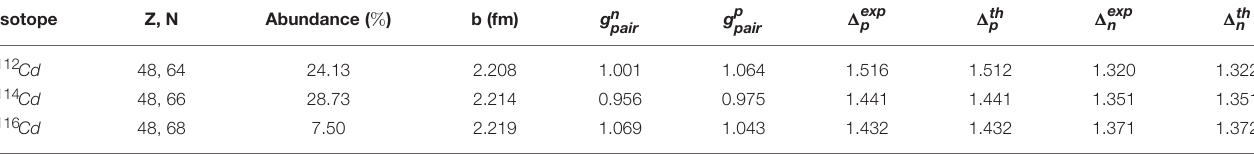
TABLE 1 | Pairing parameters g pairp (for protons), and g pairn (for neutrons) determining the monopole pairing interactions for each of the studied isotopes.